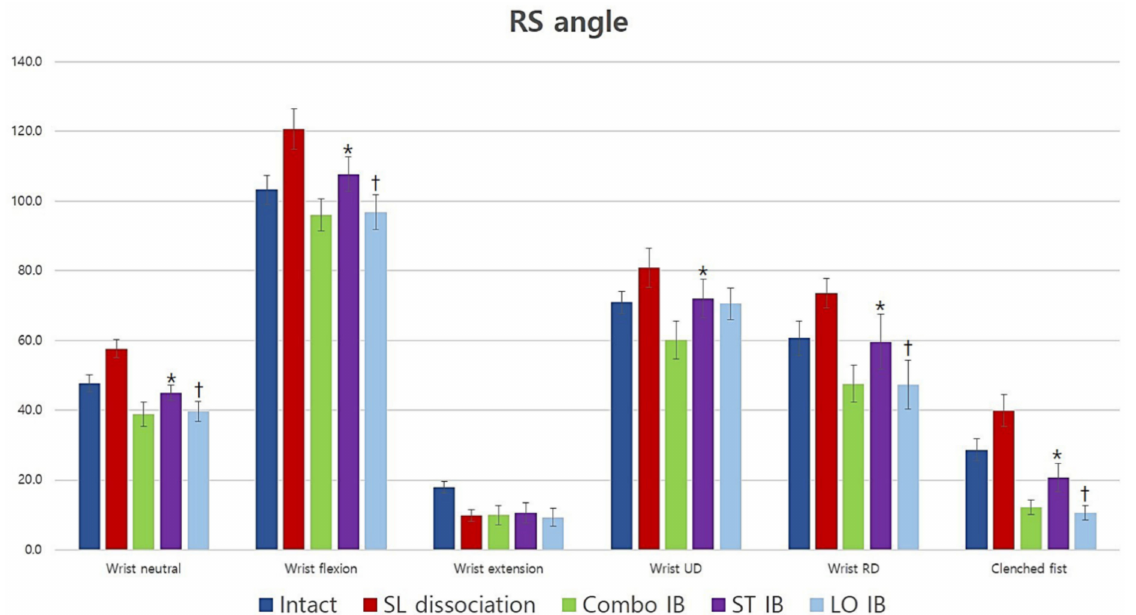
Figure 7. The average radioscaphoid angle for all conditions and positions (degrees). Short-transverse IB had less effect than long-oblique and Combo IB; however, long-oblique and Combo IB had similar effects. *: Statistically significant difference compared to Combo IB ( p < 0.05), †: Statistically significant difference compared with short-transverse IB ( p < 0.05). SL: scapholunate; UD: ulnar deviation; RD: radial deviation; Combo: combination; IB: internal bracing; ST: short-transverse; LO: